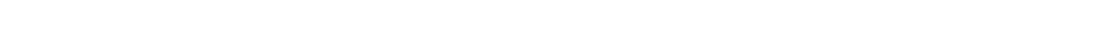
Frontiers in Genetics | Pharmacogenetics and